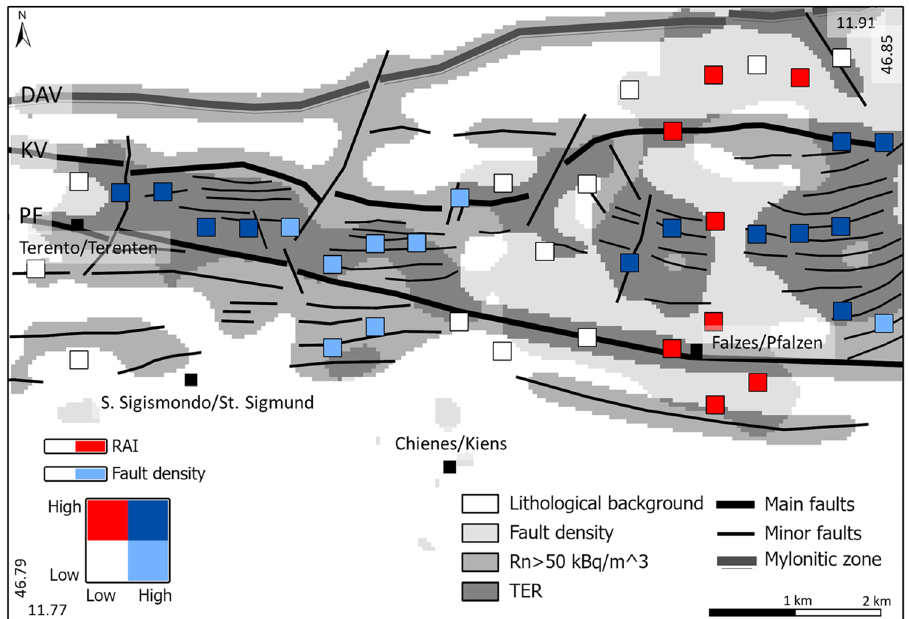
Figure 4. Summary sketch map of the areas characterised by radon fault-linked anomalies. The figure shows four different zones: (i) the lithological background (white area); (ii) the fault density (pale grey area); (iii) the area with radon activity higher than the background (> 50 kBq m −3 ) (silver grey area); (iv) the zones with high fault-linked radon values (e.g., TER) (dark grey areas). The coloured square represents the location of RAI values related to the profile peaks and have been divided as follows: (i) white squares: low RAI value, low fault density; (ii) light-blue squares: low RAI value, high fault density; (iii) red squares: high RAI values, low fault density; (iv) blue squares: high RAI values, high fault density (strictly related to the TER zones). PF = Pusteria/ Pustertal fault; KV = Kalkstein-Vallarga/Weintal fault; DAV = Deffereggen-Anterselva/Antholz-Valles/Vals mylonitic